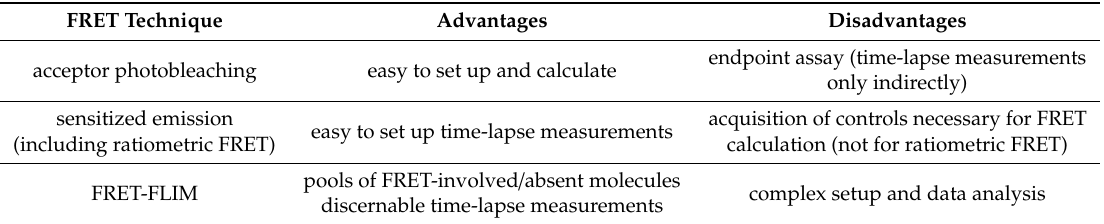
Table 3. Comparison of FRET microscopy